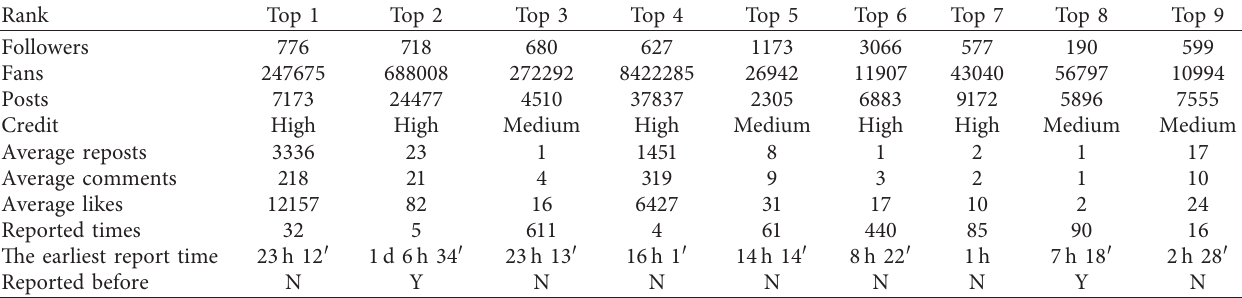
Table 5: Accounts information in the top-10 set.